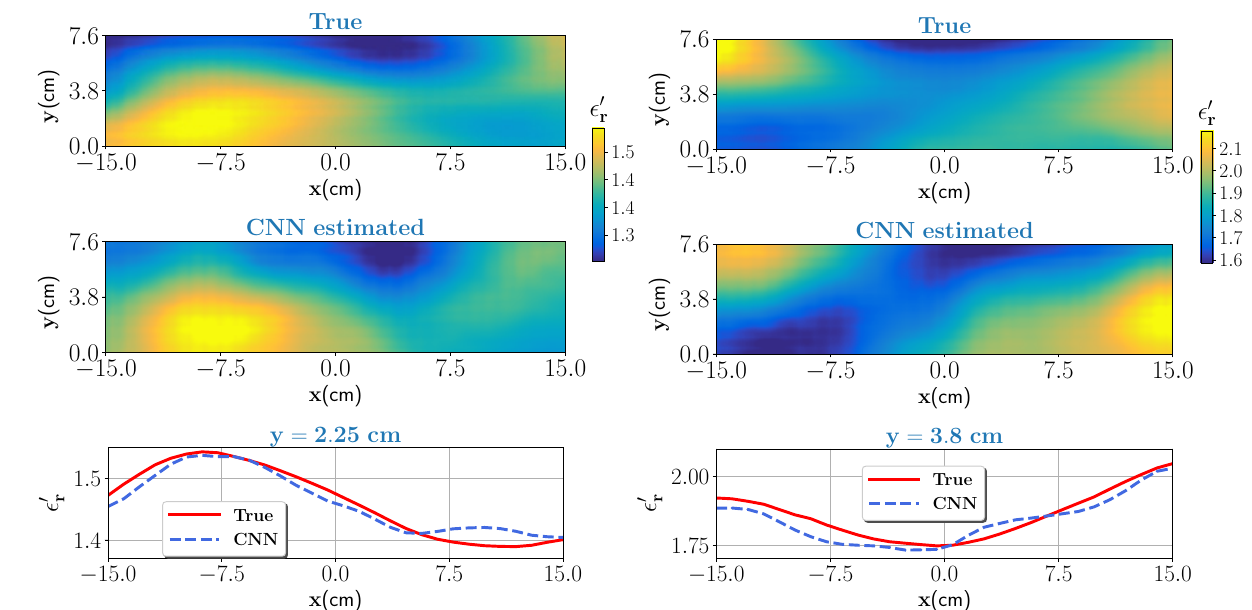
Figure 5. Low moisture case (left column): top figure shows the true profile and middle figure is the estimate from the CNN. Bottom figure compares the pixel values for the true and estimated profile at y = 2.25cm data line. Moderate moisture case (right column): same caption of the low moisture case except for the bottom figure where pixel values are compared for data line y = 3.8cm.